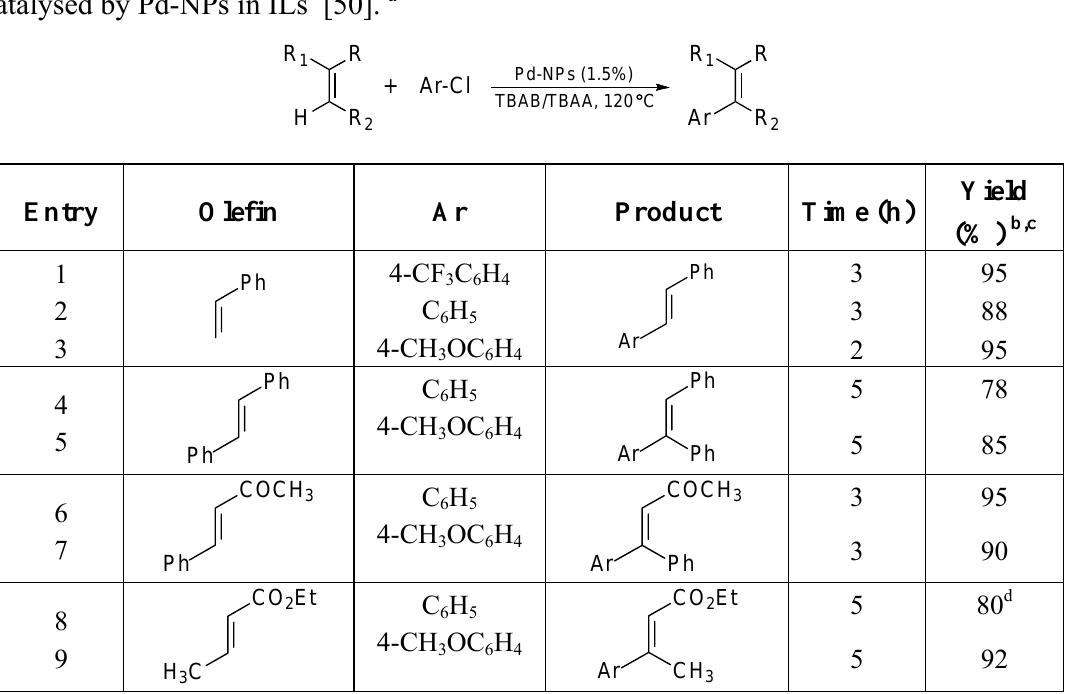
R 1 R R 1 R + Ar-Cl Pd-NPs (1.5%) TBAB/TBAA, 120 C R 2 H R 2